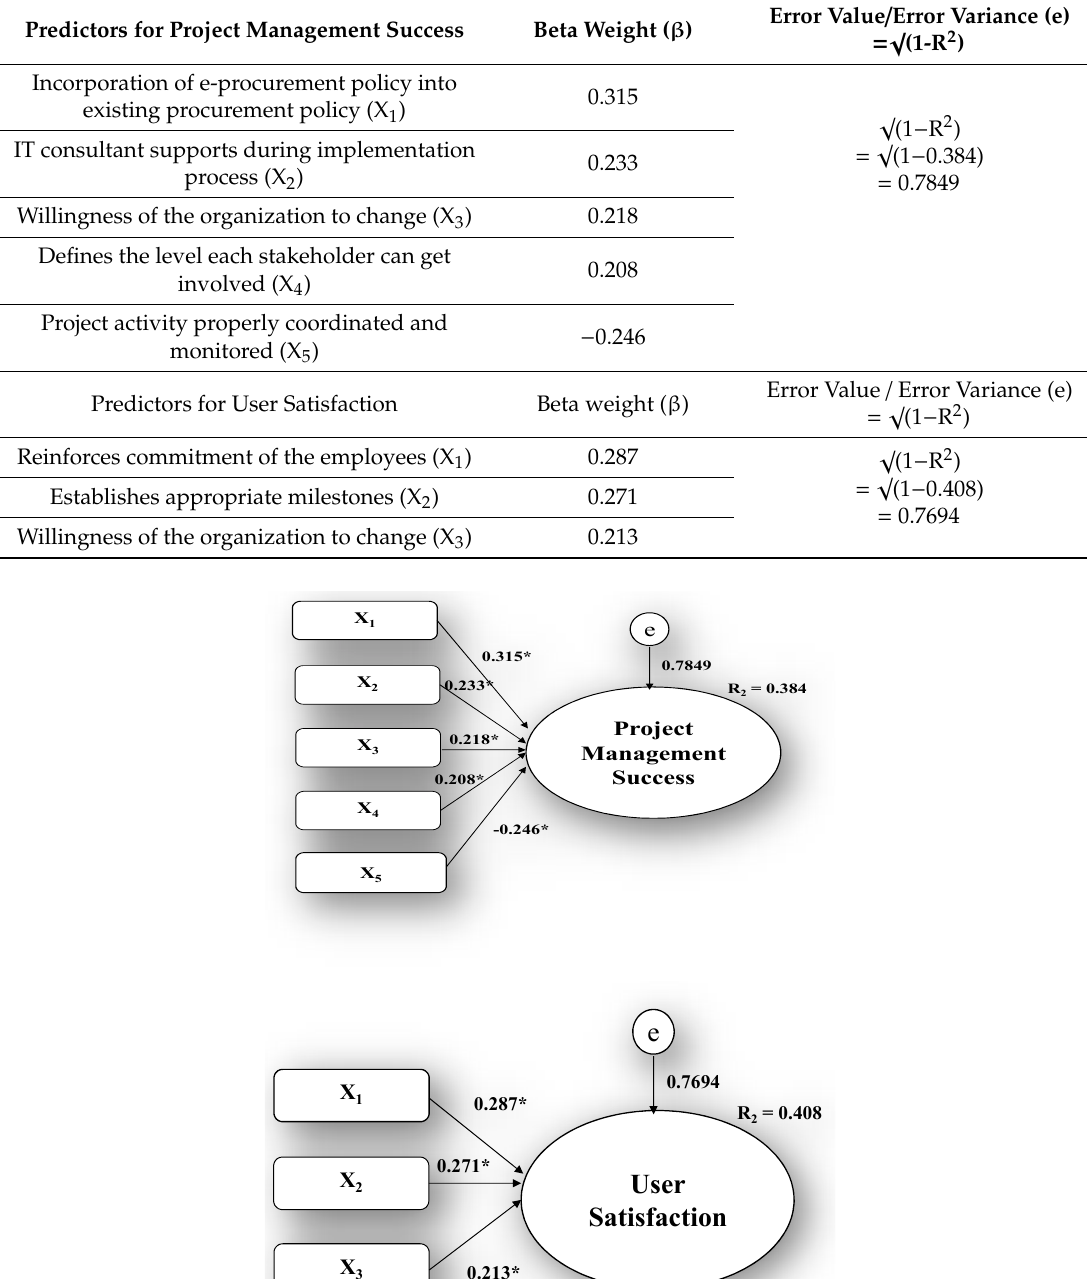
Table 4. Path coe ffi cient ( β -weight).